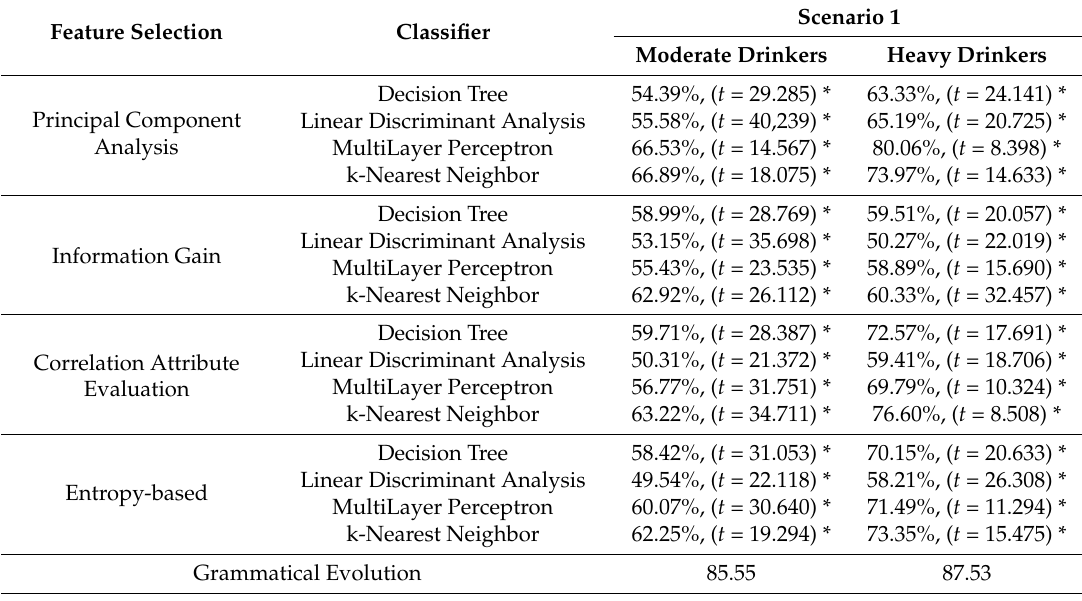
Table 2. Results in terms of accuracy for the 5 classifiers. Scenario 1 corresponds to the feature vector that contains only spectral features. In the parenthesis the statistical t -value is reported as extracted from the Paired-sample t